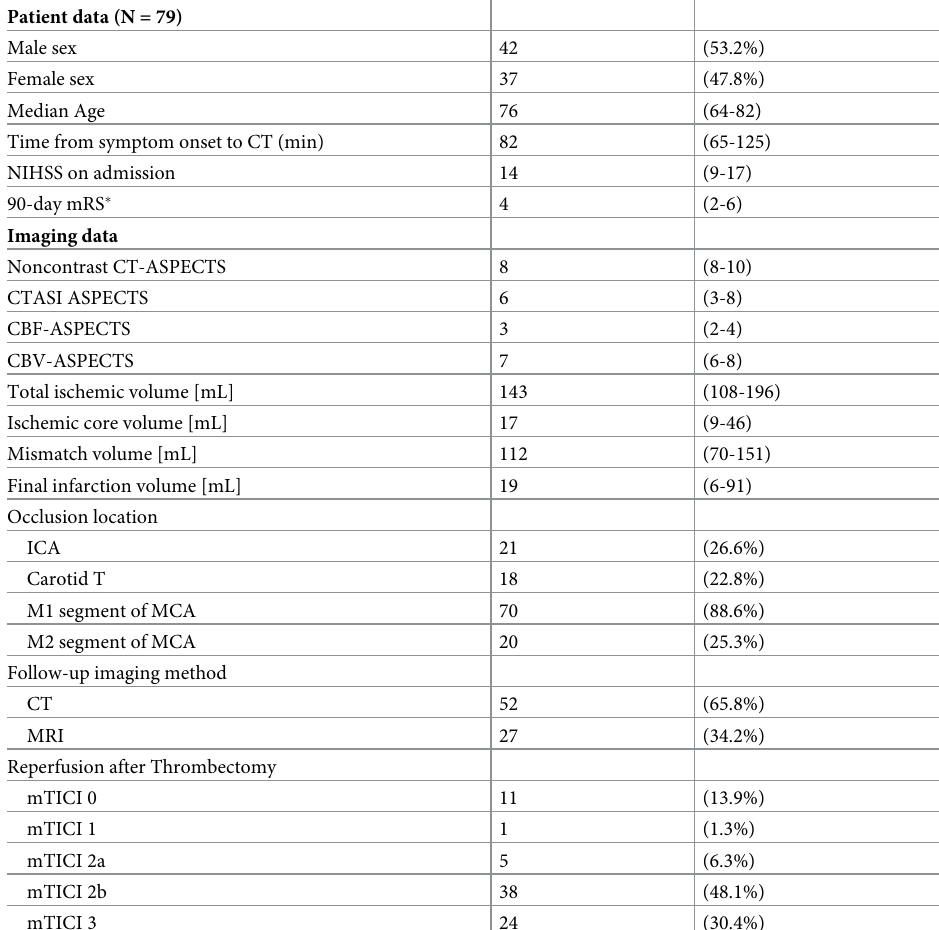
Table 1. Patient characteristics of the study population.